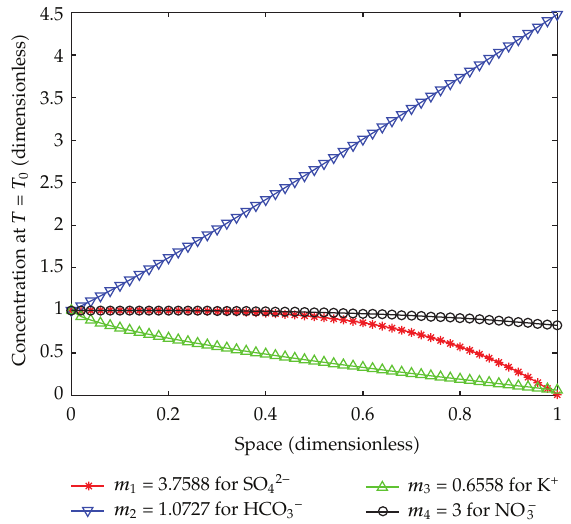
Figure 8: Space distributions at T (cid:8) T 0